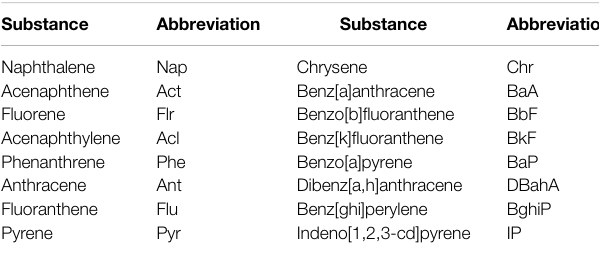
TABLE 2 | Substances and abbreviations of 16